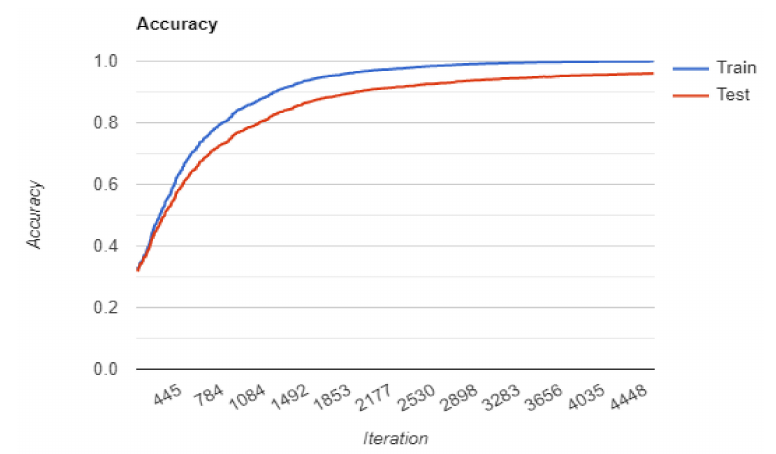
Figure 10. Accuracy curve while training on a fine-tuned set of hyperparameters.